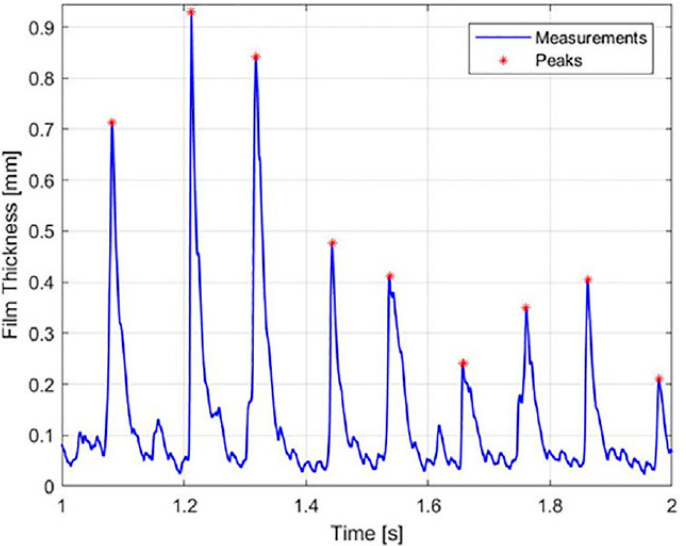
Figure 1. A temporal record of film thickness obtained by a flush-mounted conductance probe [25].